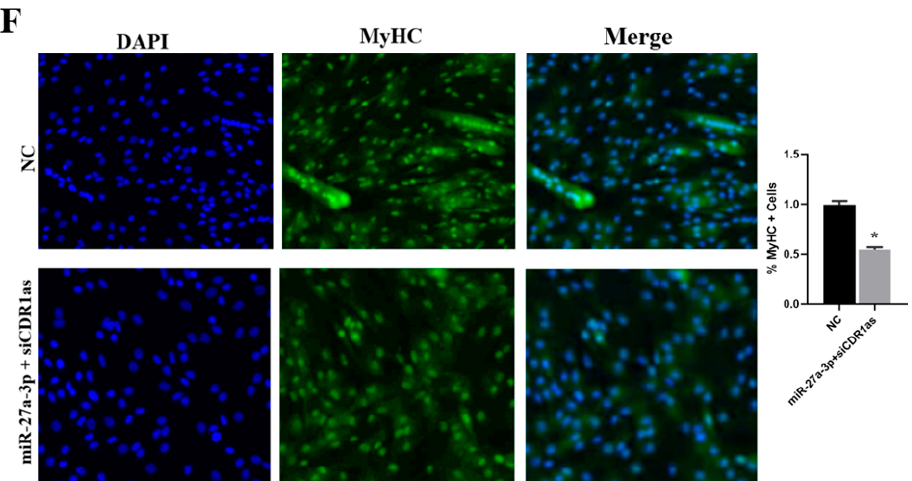
Figure 5. siCDR1as inhibits ANGPT1 via upregulation of miR-27a-3p. ( A ) Validation of the RNA expression levels of CDR1as in SMSCs transfected with siCDR1as. ( B ) RNA expression levels of MyoD after transfecting with siCDR1as. ( C ) MyHC immunofluorescence was decreased during siCDR1as. ( D ) The binding site analysis between CDR1as and miR-27a-3p. ( E ) Relative Luciferase activity of putative miR-27a-3p to pCK-CDR1as-WT/Mutant. ( F ) SMSCs transfected with siCDR1as+miR-27a-3p, cell differentiation was detected by immunofluorescence (MyHC) and MyHC positive cells. The number of ‘’*” indicates the level of significance (**, p < 0.01, *, p < 0.05). The p values were analyzed by Student’s t -test; p < 0.05.